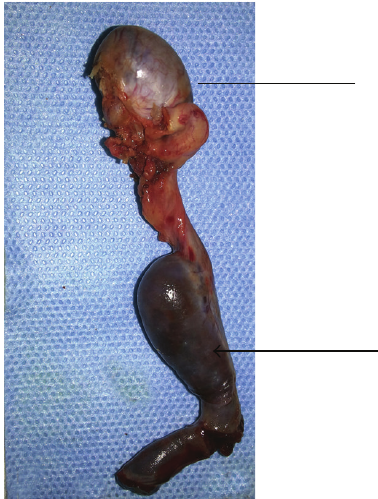
Figure 3: Resected specimen of the left orchidectomy with fused splenictissue(splenicportionmarkedwitharrow-lineandtesticular portion marked with line only).